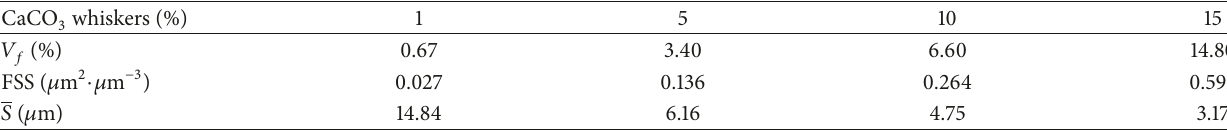
Figure 20: (a) The CaCO 3 whisker filling the crack. (b) The bridging effect of CaCO 3 whisker. (c) Pull-out effect of CaCO 3 whisker. (d) Confined crack developing. (e) the CaCO 3 whiskers scattered unevenly. Table 5: The parameters of the physical